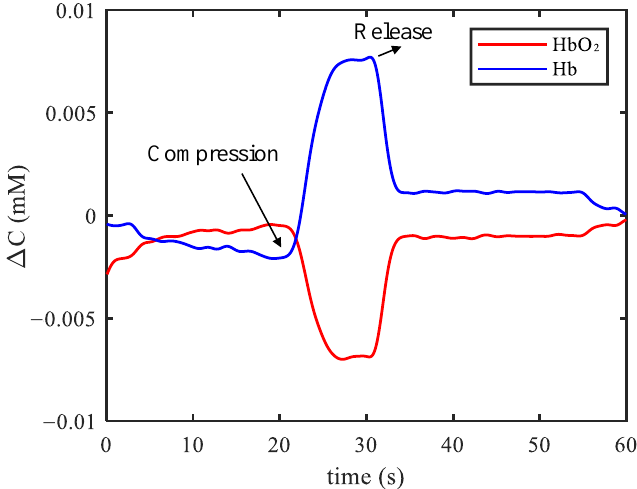
Figure 7. Example of results in the forearm arterial occlusion